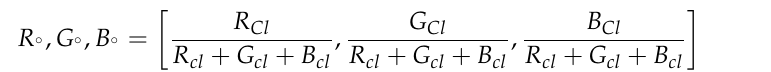
Figure 2. Sample images from dataset.